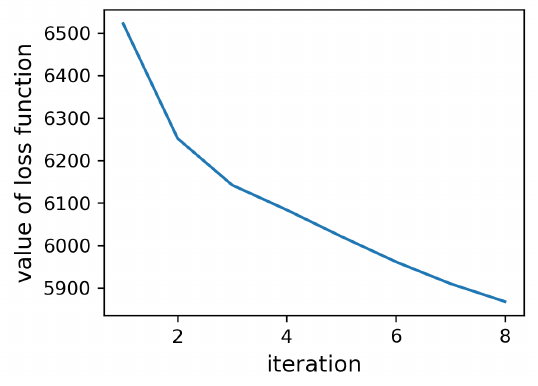
Figure 9. The curve of loss function in the data from nine examinations.